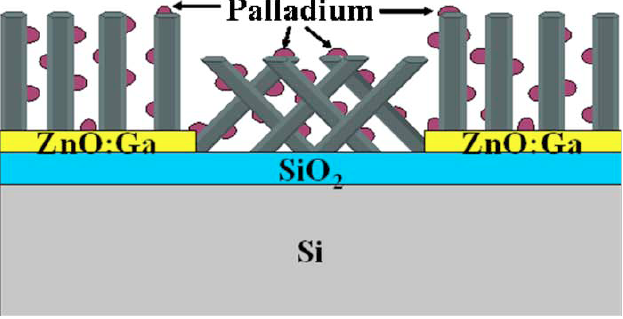
Figure 8. Schematic for the the cross sectional view of ZnO nanowire array deposited with Pd nanoparticles